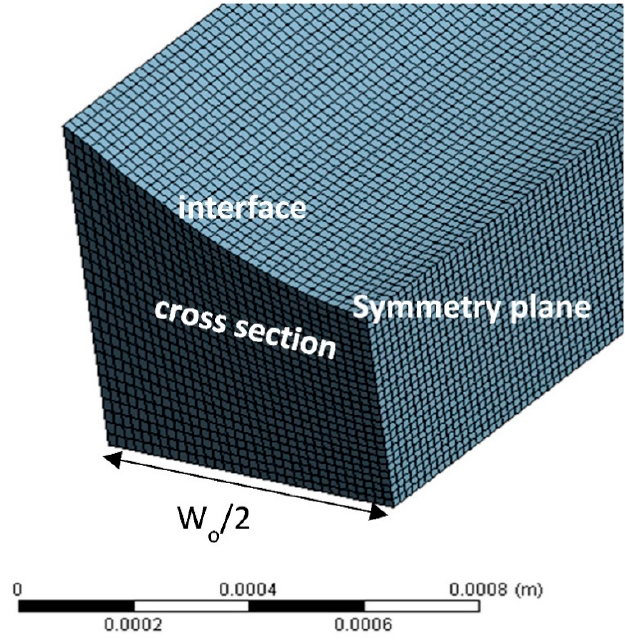
Figure 7. Grid density of the simulation.